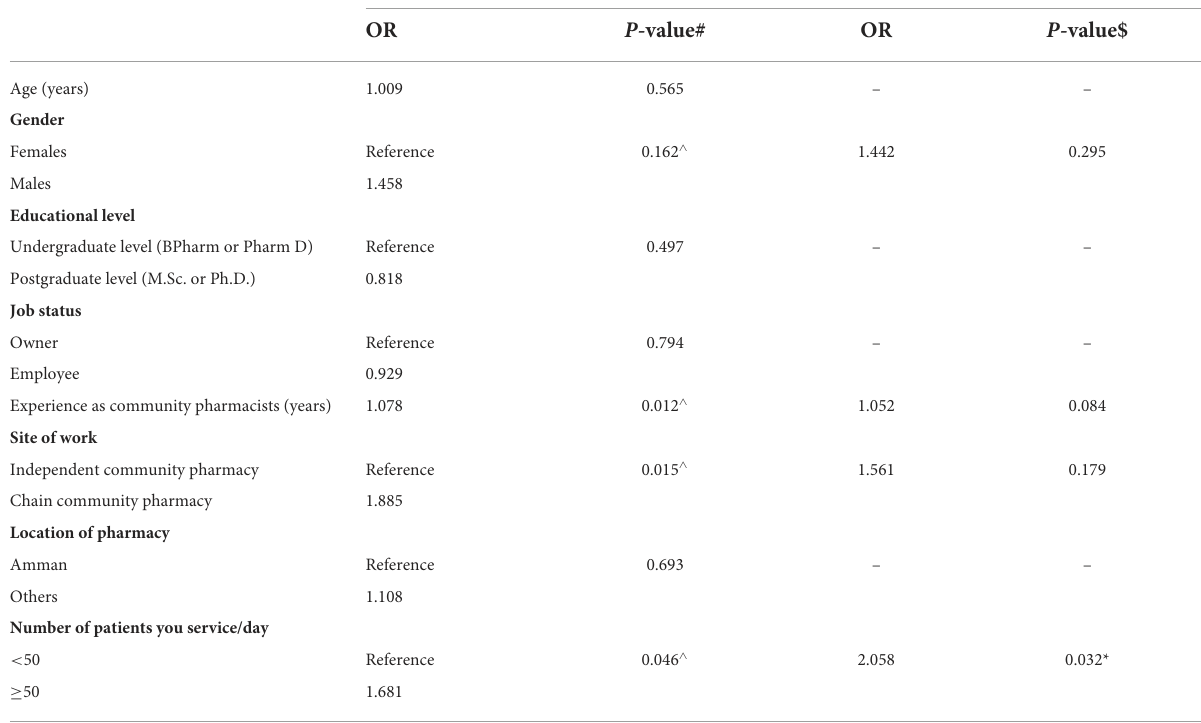
TABLE 4 Assessment of factors associated with pharmacists’ willingness to use home delivery of medications service ( n =